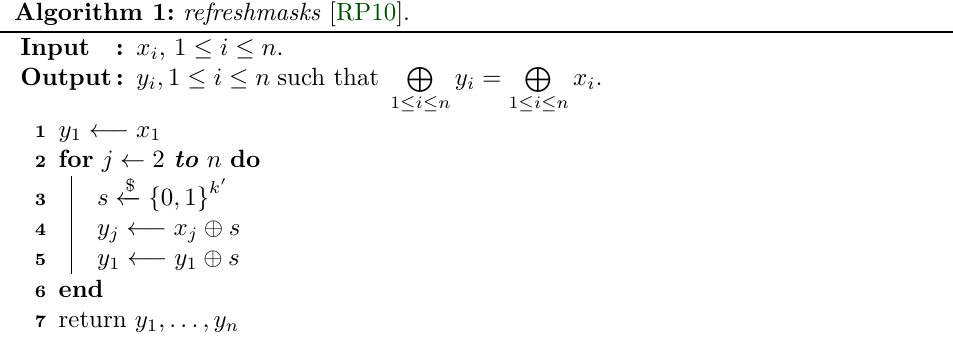
Algorithm 1: refreshmasks